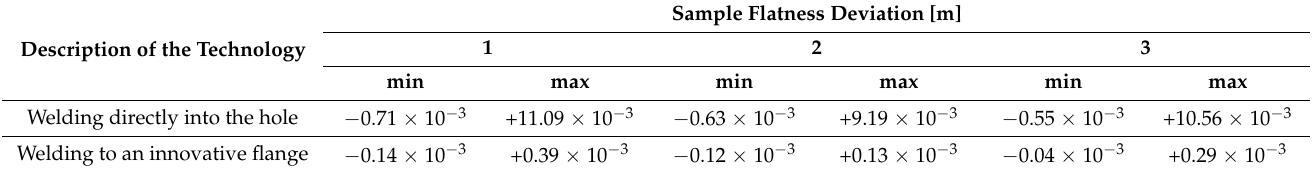
Table 5. Summary of the measurement results of the flatness deviation values of two scanned elements.